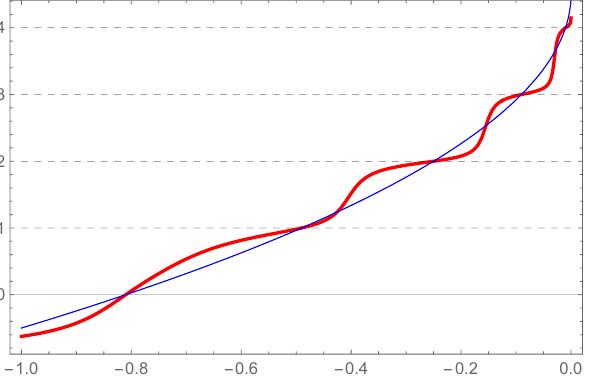
Figure 4. Two counting functions of the Morse potential. The (red) thick line is Milne’s one, and the (blue) thin line is N exact ( E )